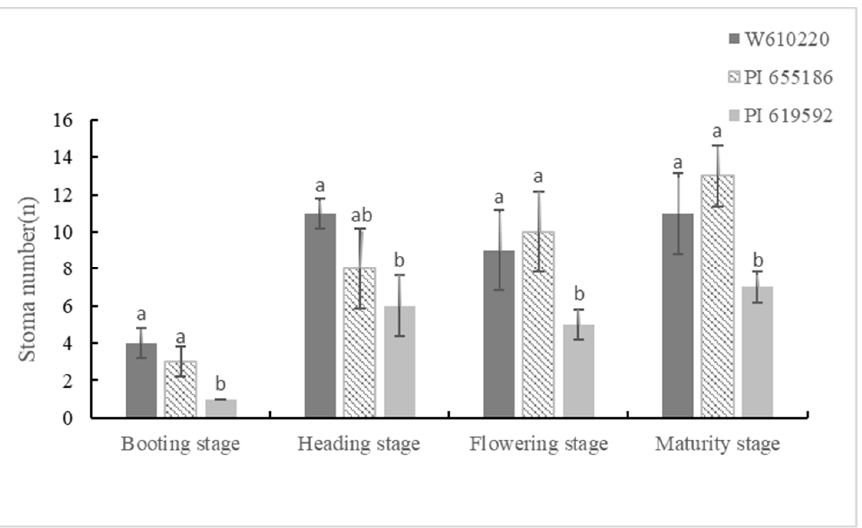
Figure 5. The number of stomas in the lower part of awns of three accessions at four developmental stages. W610220, long awn, PI 655186, medium awn, PI 619592, short awn. Error bars represent mean ± standard deviation. Different normal letters mean significant differences among different treatments at 0.05